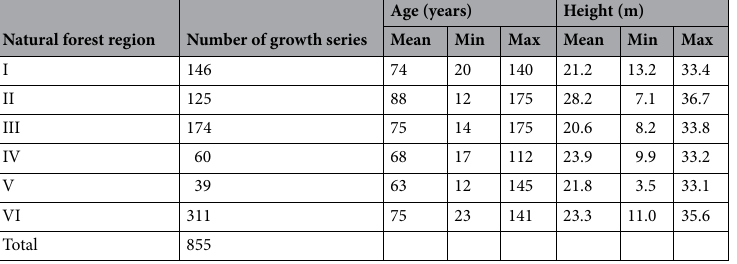
Table 1. The number and basic characteristics of growth series for the Scots pine trees, obtained from stem analysis and used for the development of the site index